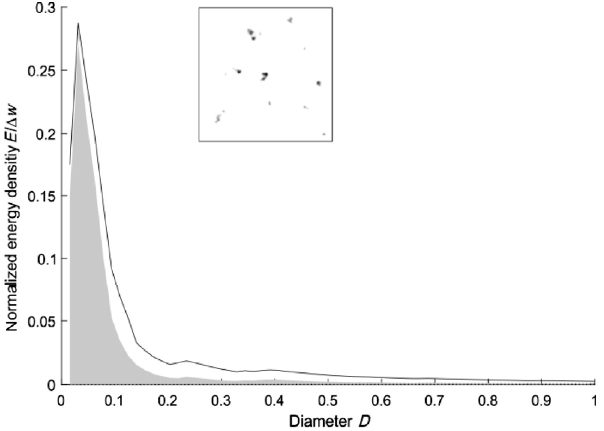
Fig. 4 Dependency of the energy density at the given contact configuration as a function of the diameter D of probing circles. The grey zone is limited by the minimum and maximum values that occur. The contact configuration which has been analyzed is shown in the insert. It was generated using the